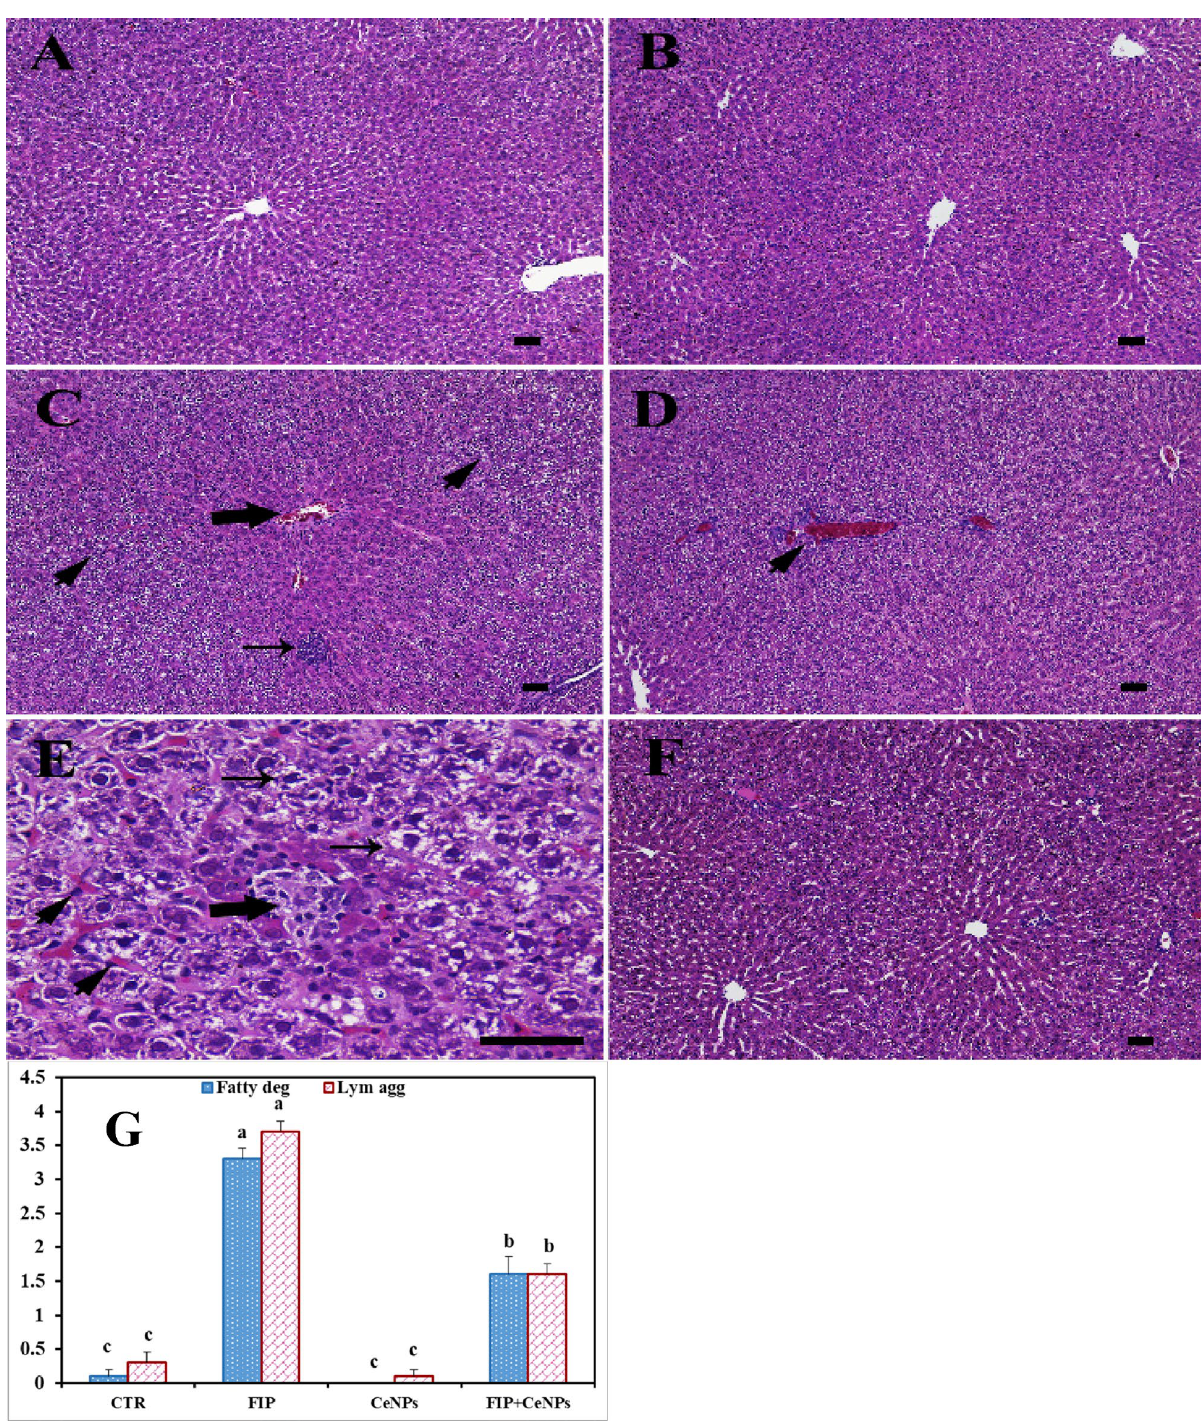
Figure 1. Histopathological examination of rat liver. ( A ) Negative control group. ( B ) CeNPs group. ( C – E ) FIP group showing in ( C ) congested central vein (arrow), massive fatty degeneration in the periportal areas (arrowheads) and lymphocytic aggregation (arrow) in between massive fatty degeneration (arrowheads). ( D ) Highly congested portal vein surrounded with lymphocytic infiltration (arrowhead). ( E ) Necrotic foci (thick arrow), congested liver sinusoids (arrowheads) and fatty degeneration (thin arrows). ( F ) FIP group that treated with CeNPs. Scale bar = 50 µm. ( G ) H&E semi quantitative scoring of hepatic fatty degeneration and lymphocytic aggregations. Data expressed as Mean ± SE, analyzed using one-way ANOVA at P ≤ 0.05, column with different letters (a, b & c) indicate significant difference among the values of different